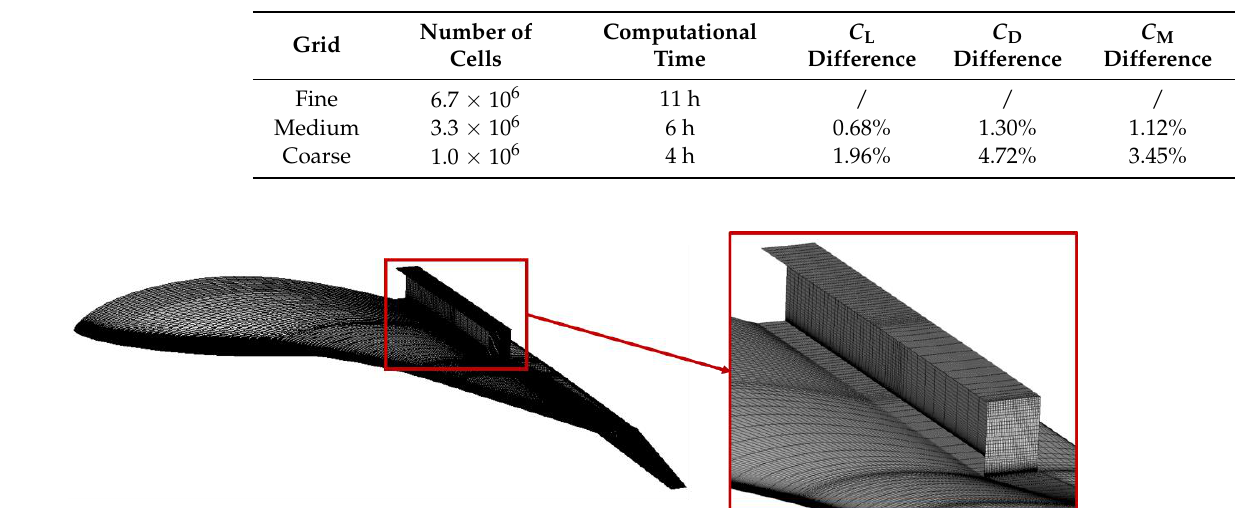
Figure 8 . Computational mesh around the half model of the BWB configuration with simplified DEP system.